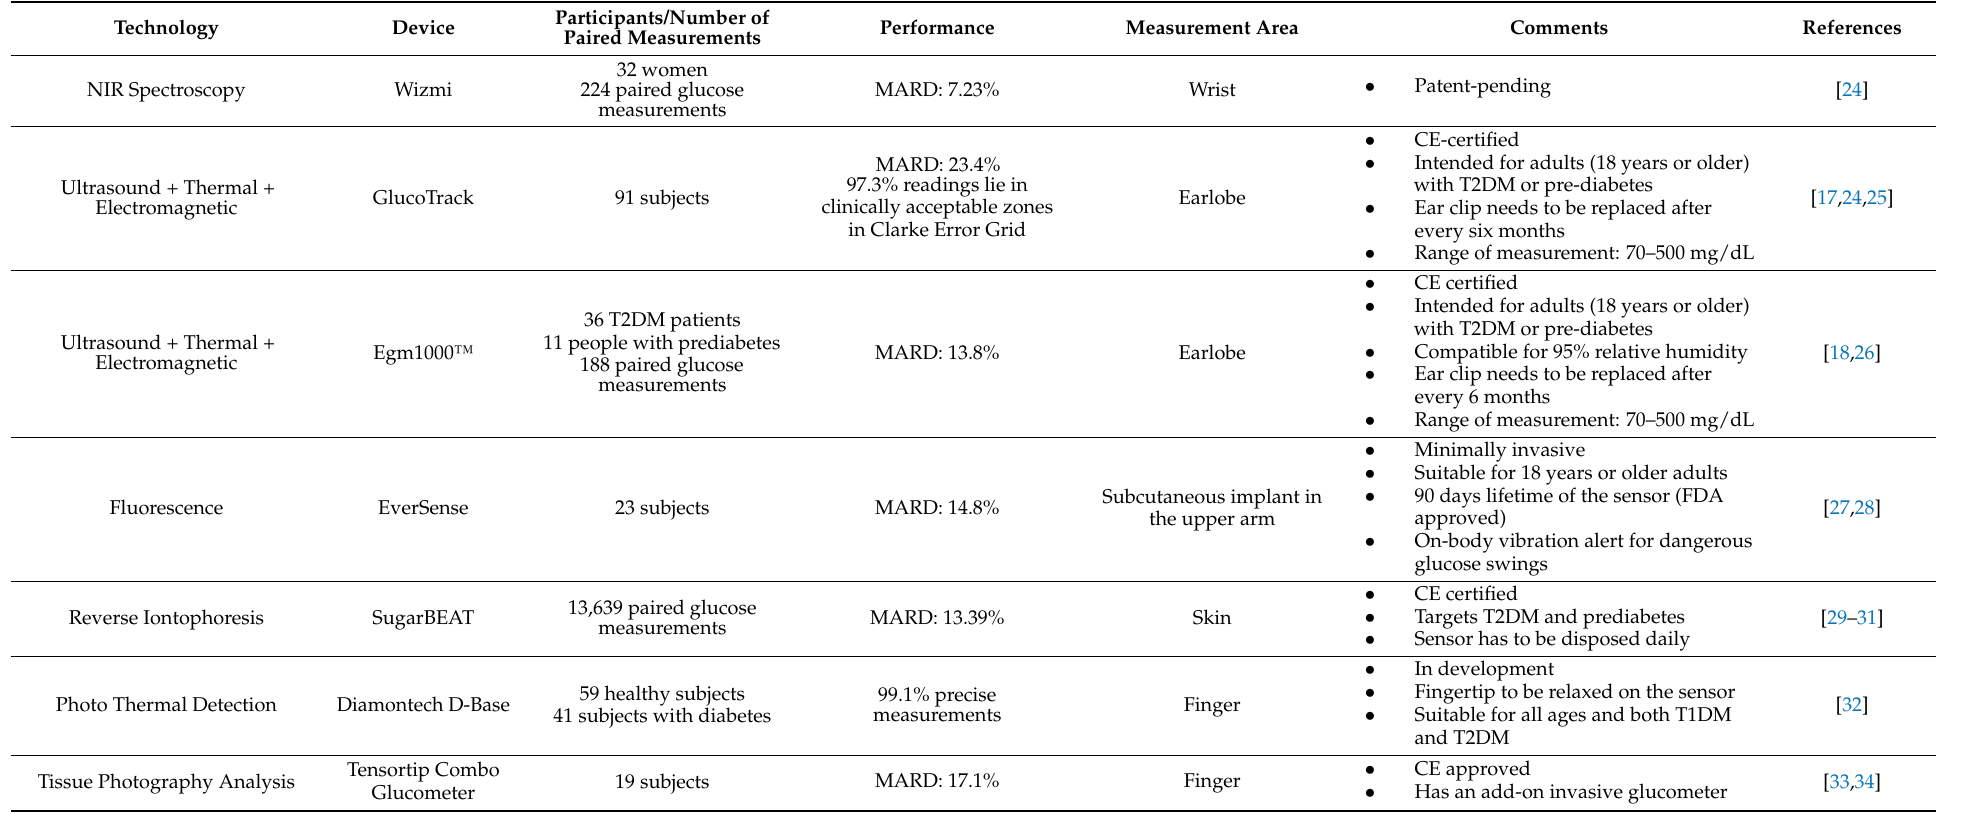
Table 1. Glucose-monitoring devices working on non-invasive/minimally invasive